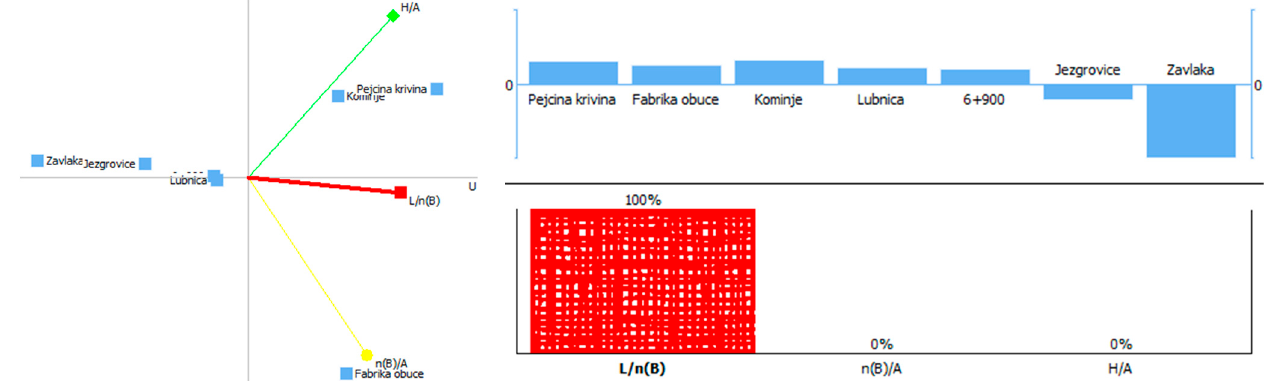
Figure 9. Optimization solutions for the S 1 scenario “Kominja” with Φ =